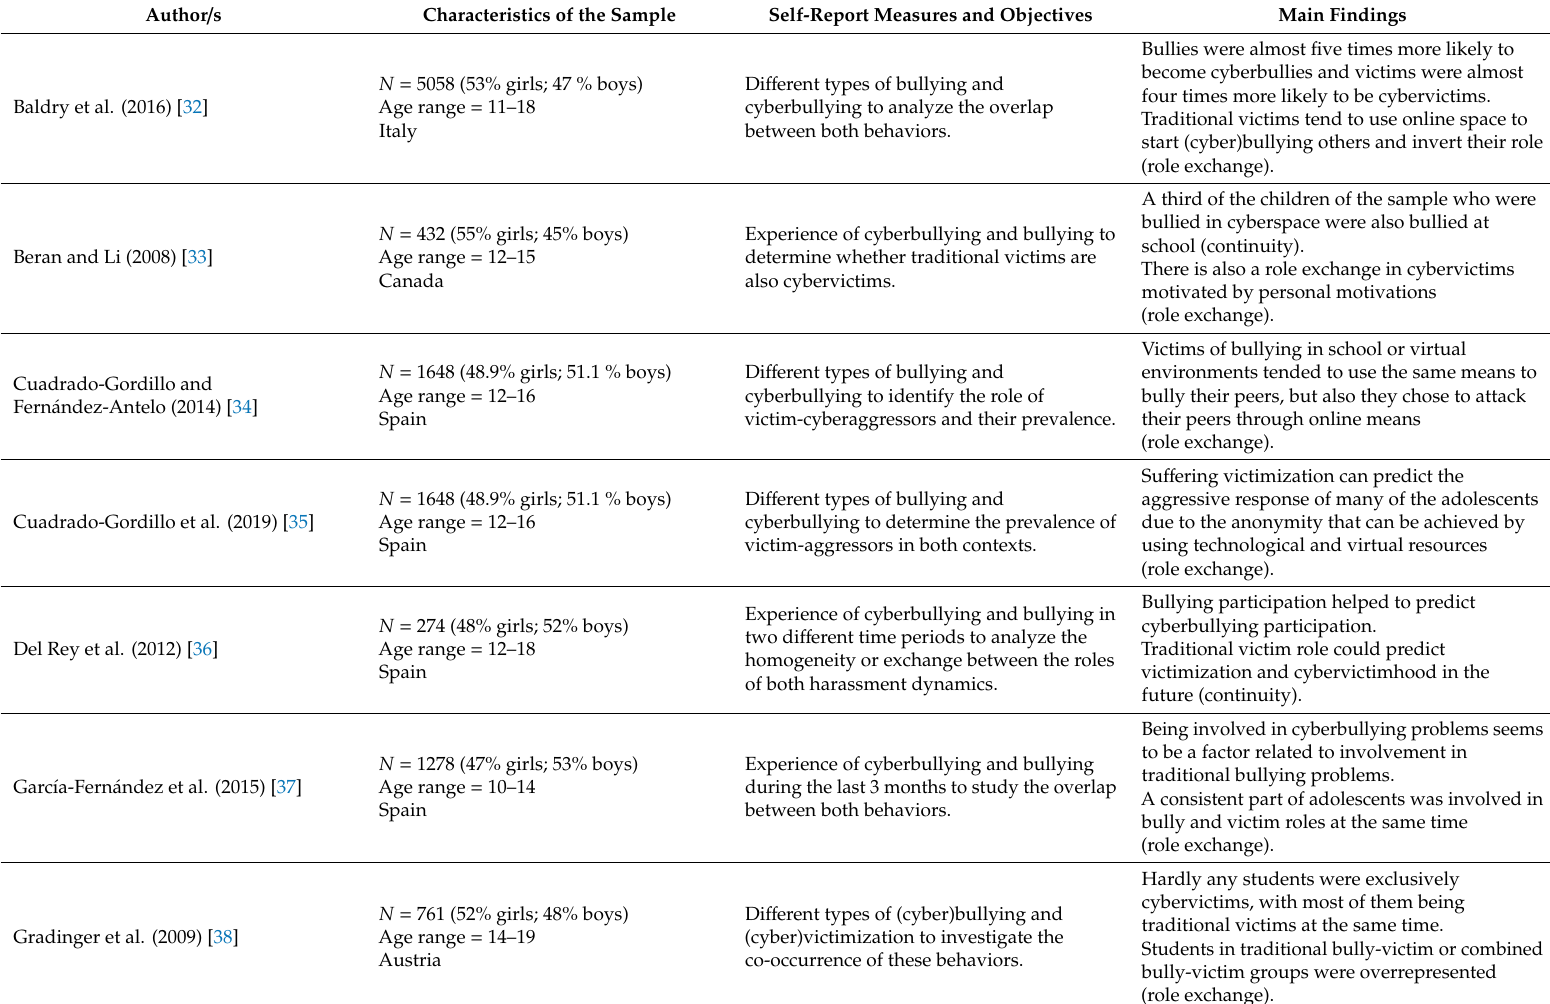
Table 2. Summary of selected